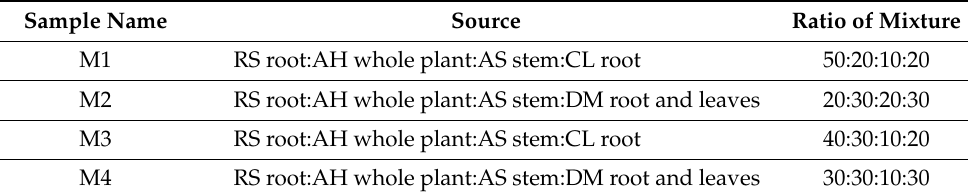
Table 2. Optimal composition of SSM.